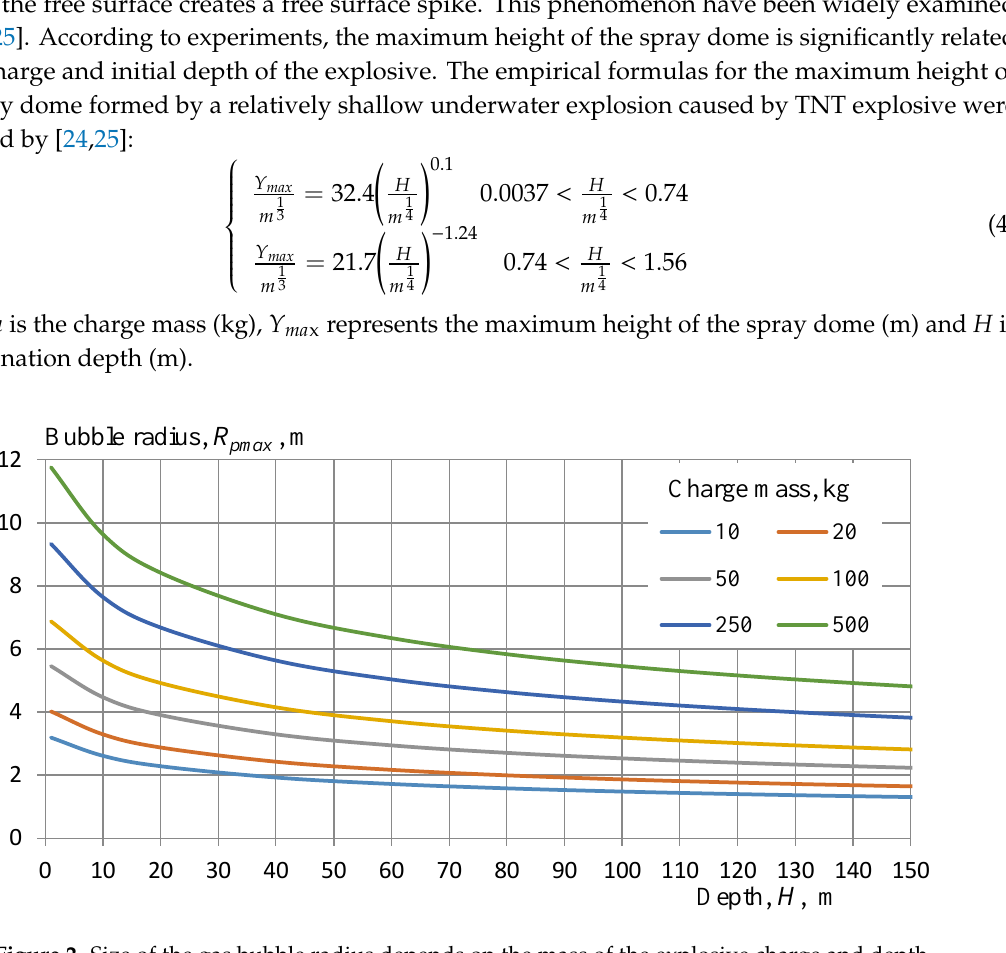
Figure 2. Size of the gas bubble radius depends on the mass of the explosive charge and depth.